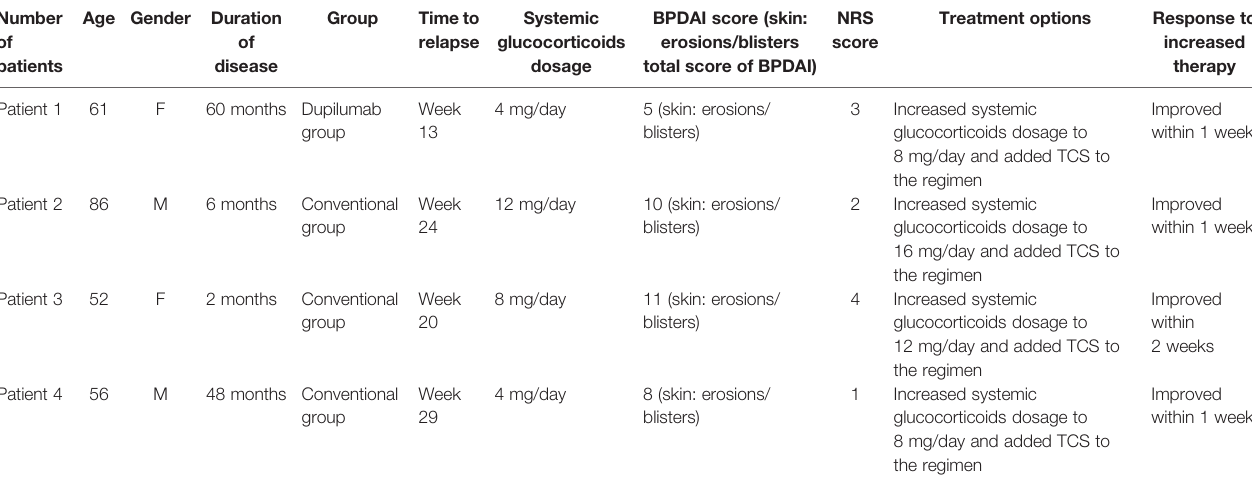
TABLE 2 | Details of relapsed cases in both groups.